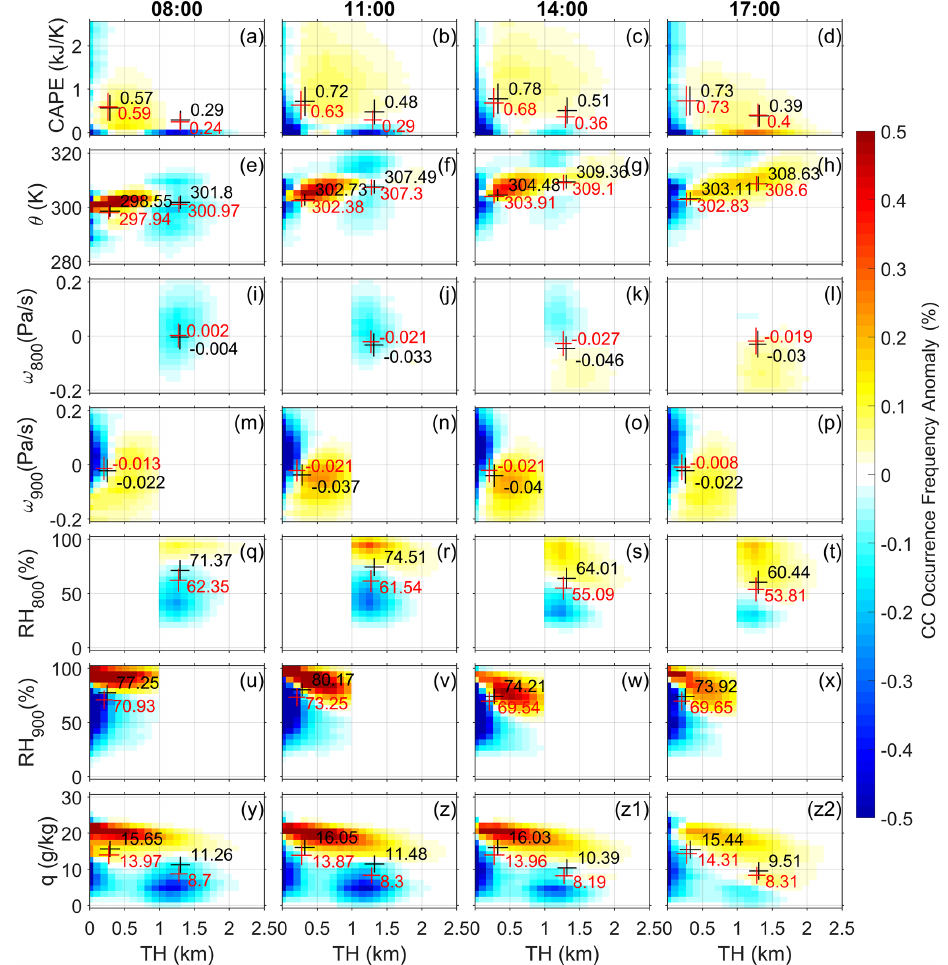
Figure 5. Over-land convective cloud occurrence frequency (CCOF) anomaly with respect to terrain height (TH) and (a–d) convective available potential energy (CAPE), (e–h) potential temperature ( θ ), (i–l) vertical pressure velocity at 800hPa ( ω 800 ) over terrain above 1000m, (m–p) vertical pressure velocity at 900hPa ( ω 900 ) over terrain below 1000m, (q–t) relative humidity at 800hPa (RH 800 ) over terrain above 1000m, (u–x) relative humidity at 900hPa (RH 900 ) over terrain below 1000m, and (y–z2) specific humidity at 2m ( q ). The columns represent local times over the ROI of 08:00, 11:00, 14:00, and 17:00, respectively. Black (red) crosses and the numbers beside them mark the mean values of the variables with convective cloud (under all-sky conditions) over regions with terrain height below 1000m and above 1000m; crosses mark the SDs of the variables. Grid points are plotted only if they exceed the 95% significance level ( p < 0.05) according to the Pearson χ 2